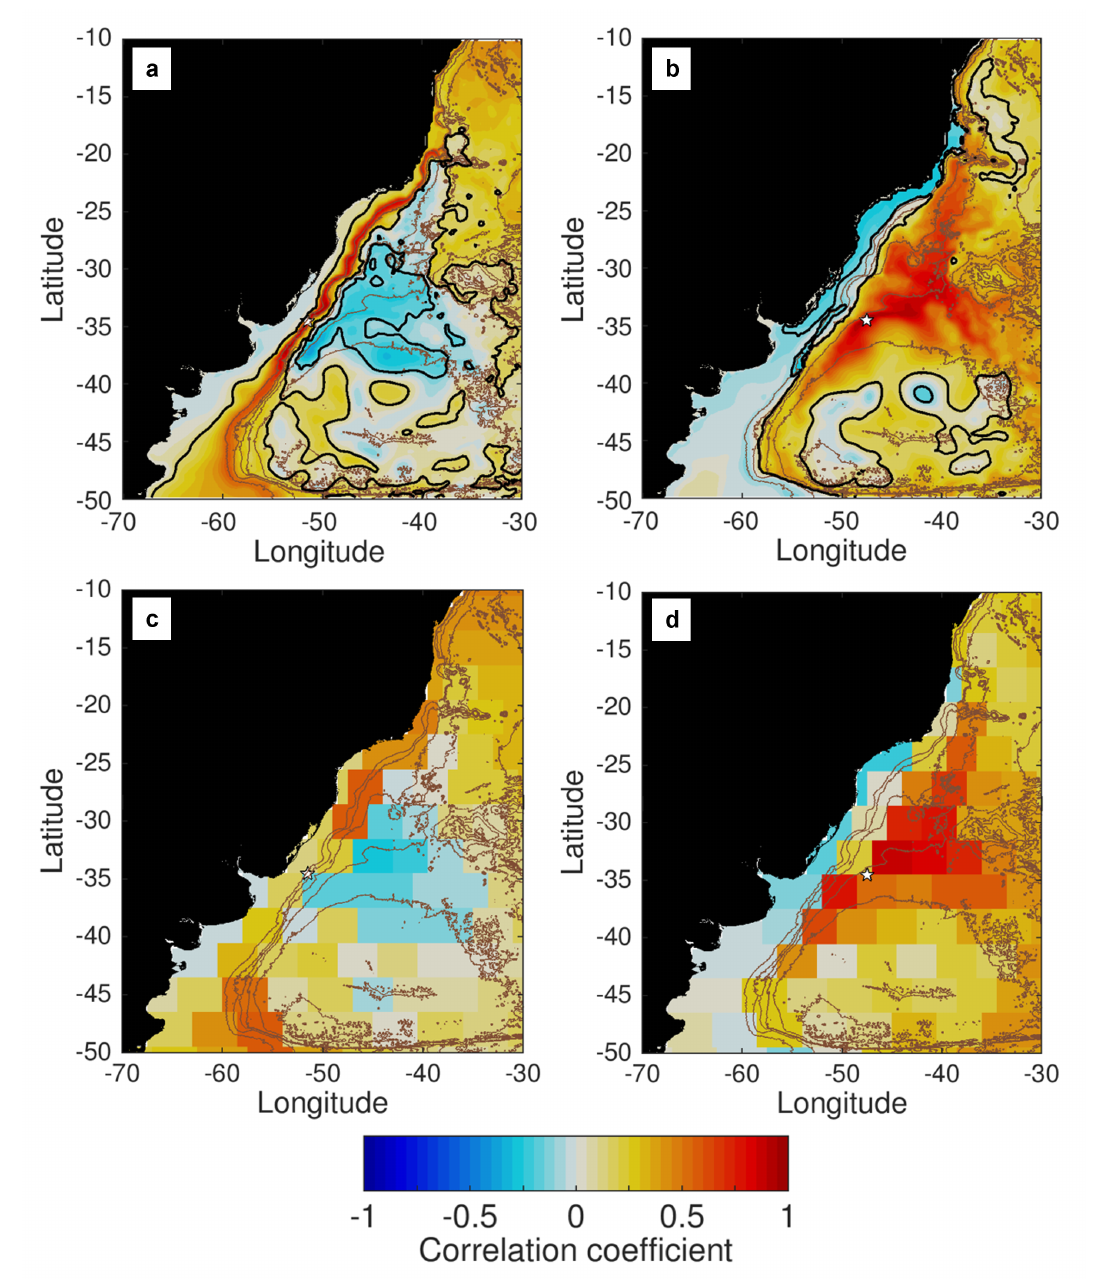
Figure 1. ( a ) Correlation of OBP at 34.5 ◦ S, 51.5 ◦ W ( ∼ 1500 m depth) with OBP in the surrounding region in the ECCO2 CS510 simulation, bandpassed for 3–12 month timescales with the seasonal cycle removed. Thin brown contours indicate bathymetry at intervals of 1000 m; thick black contours indicate correlation significance at the 95% confidence level. ( b ) Same as ( a ) but for OBP correlation with 34.5 ◦ S, 47.5 ◦ W ( ∼ 4400 m depth). ( c ) Correlation of OBP at 34.5 ◦ S, 51.5 ◦ W with surrounding synthetic mascons, 3–12 month timescales, and ( d ) same but for correlation with 34.5 ◦ S, 47.5 ◦